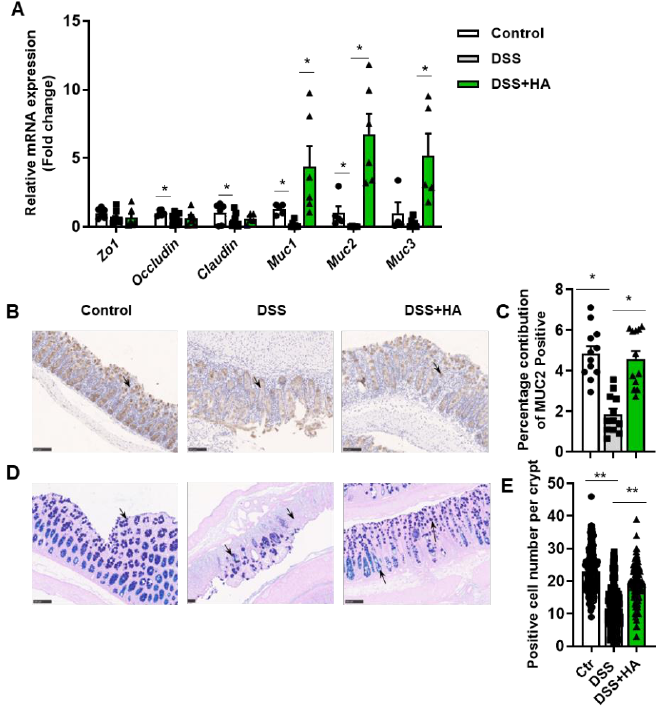
Figure 2. HA improves mucosal barrier. ( A ) Relative mRNA expression of tight junction genes and mucin genes in the colon. ( B , C ) Immunohistochemical analysis of MUC2 in the colon (20×). ( D , E ) PAS-AB staining of the colon (20×). Data are expressed as mean ± SE, n = 8 – 10, * p < 0.05, ** p <